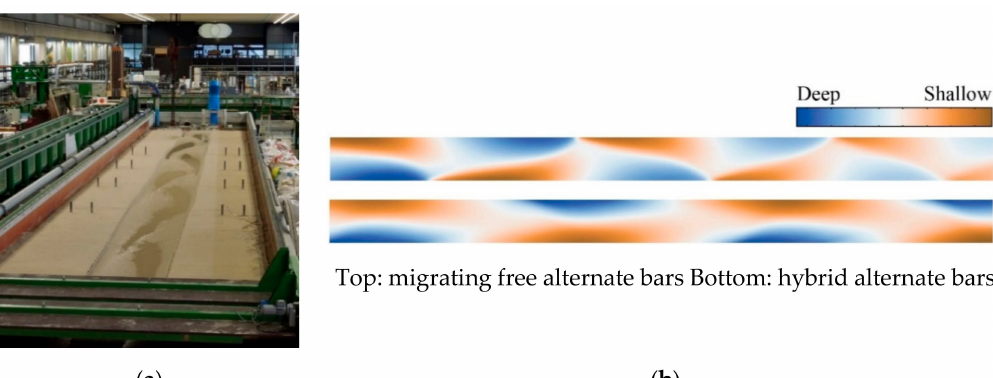
Figure 6. ( a ) Free bars migrating in downstream direction in the laboratory. Flow direction from bottom to top (courtesy of Andr é s Vargas-Luna). ( b ) Comparison between the shape and size of free bars migrating in downstream direction (channel above) and of steady hybrid bars (channel below) obtained with identical boundary conditions in a 2D numerical model constructed with the Delft3D code (courtesy of Le Thai Binh). Flow direction from left to right.